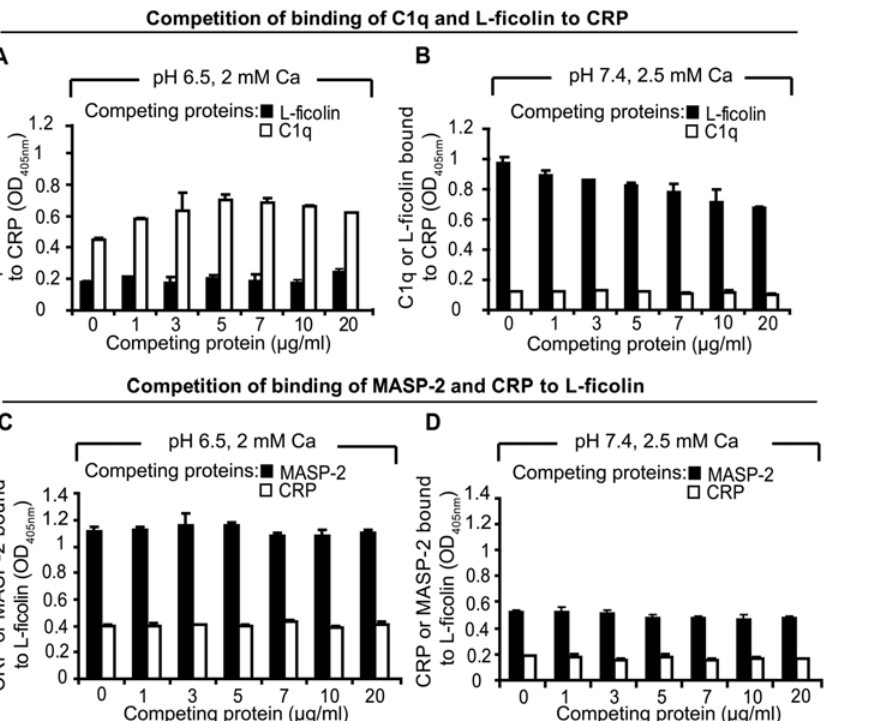
Figure 4. Co-existence of the amplification pathways and the classical and lectin pathways. (A) Competition of binding of C1q and L- ficolin to CRP at pH 6.5 and 2 mM calcium. 0.8 m g of C1q mixed with increasing amounts of L-ficolin (black bars) or 0.8 m g of L-ficolin mixed with increasing amount of C1q (white bars) in blocking buffer (MBS with 0.05% Tween-20 and 1% HSA, pH 6.5) was added to the immobilized CRP. The amount of bound C1q (black bars) or L-ficolin (white bars) was detected by the corresponding antibodies. (B) Competition of binding of C1q and L- ficolin to CRP at pH 7.4 and 2.5 mM calcium. 0.8 m g of C1q mixed with increasing amount of L-ficolin (black bars) or 0.8 m g of L-ficolin mixed with increasing amount of C1q (white bars) in blocking buffer (TBS with 0.05% Tween-20 and 1% HSA, pH 7.4) was added to the immobilized CRP. The bound C1q (black bars) or L-ficolin (white bars) was detected by the corresponding antibodies. (C) Competition of binding of MASP-2 and CRP to L- ficolin at pH 6.5 and 2 mM calcium. 0.8 m g of CRP mixed with increasing amount of MASP-2 (black bars) or 0.8 m g of MASP-2 mixed with increasing amount of CRP (white bars) in blocking buffer (MBS with 0.05% Tween-20 and 1% HSA, pH 6.5) was added to the immobilized L-ficolin. The bound CRP (black bars) or MASP-2 (white bars) was detected by the corresponding antibodies. (D) Competition of binding of MASP-2 and CRP to L-ficolin at pH 7.4 and 2.5 mM calcium. 0.8 m g of CRP mixed with increasing amount of MASP-2 (black bars) or 0.8 m g of MASP-2 mixed with increasing amount of CRP (white bars) in blocking buffer (TBS with 0.05% Tween-20 and 1% HSA, pH 7.4) was added to the immobilized L-ficolin. The bound CRP (black bars) or MASP-2 (white bars) was detected by the corresponding antibodies. 0.8 m g of HSA immobilized on the wells instead of CRP was the negative control and readings were subtracted off the negative controls. Ca annotates